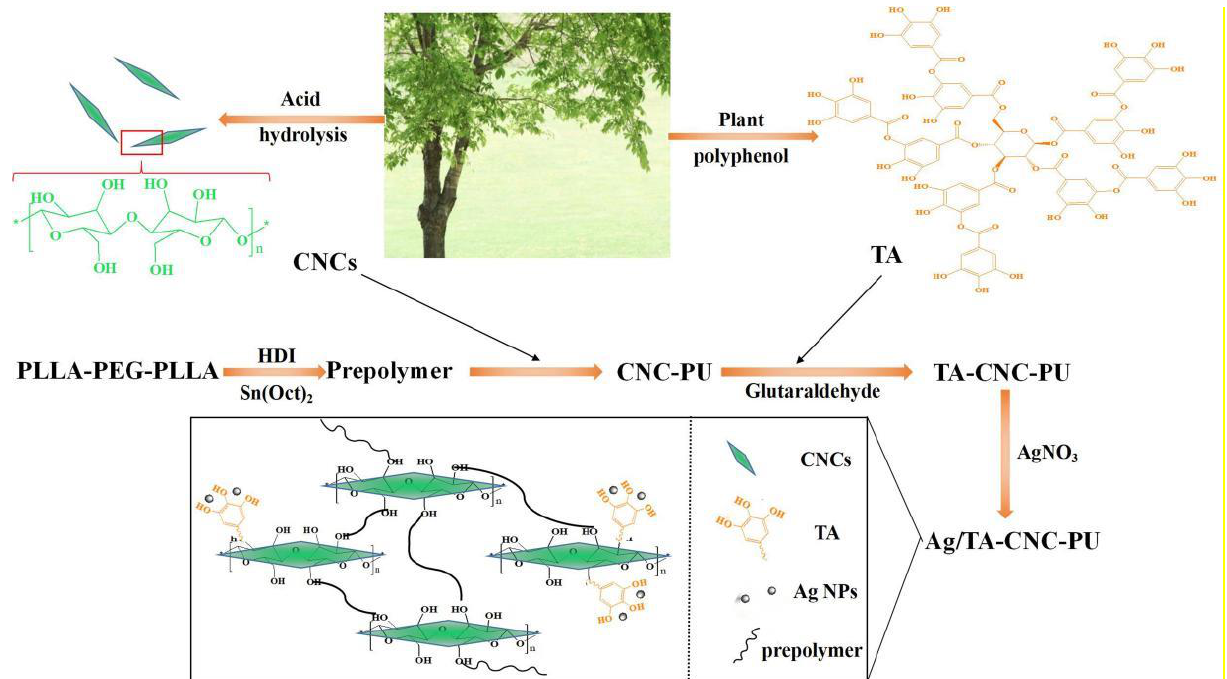
Figure 1. The preparation process of